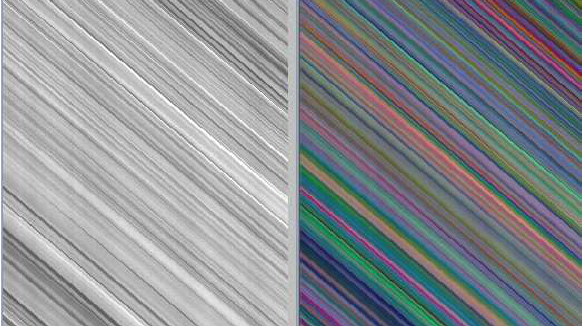
Figure 8. Example of AMETHIST PA and XS images